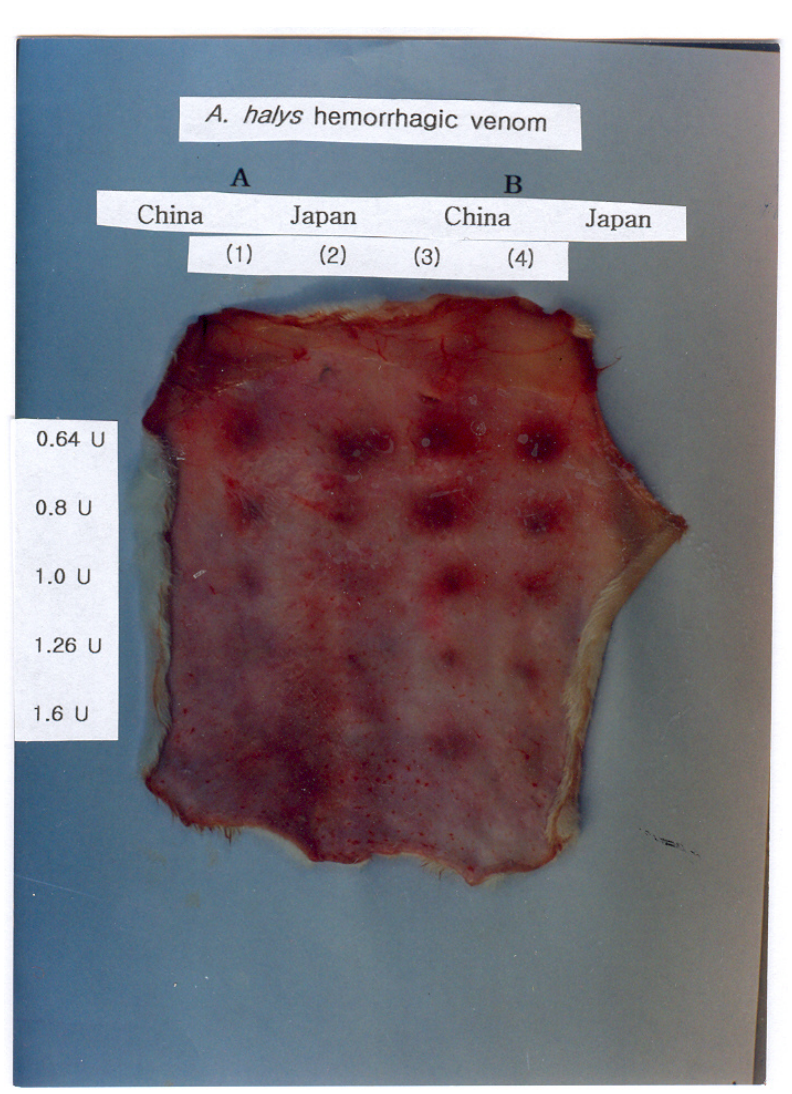
Figure 5: Neutralization of Agkistrodon halys venom by Agkistrodon halys antivenom from Japan (2, 4) and Jiangzhe Agkistrodon halys antivenom from China (1, 3). Equal volumes of each diluted antivenom (0.64 U/ml-1.0 U/ml) were mixed with 83 µg of Agkistrodon halys venom A, B: Duplicate